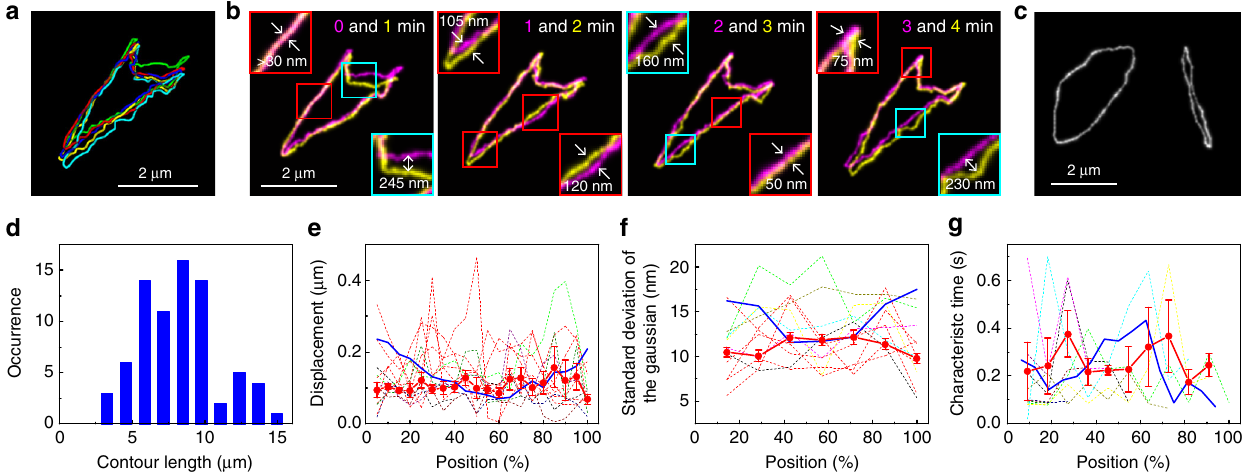
Fig. 6 Analysis of the motion of the entangled cyclic DNA molecules. a Superimposed 3D contours of the Cy5-labelled Charomid 9-42 DNA in an aqueous solution containing 10 mg ml − 1 concentration of non-labelled lambda DNA. b 2D projected contours of the DNA molecule displayed in a . The local widths of the contours correspond to the standard deviations of the Gaussian at each local segment. Two contours obtained from adjacent time frames are shown in each panel in cyan and yellow. Insets show enlarged views of the areas highlighted by the squares. c Examples of the 2D projected contours of the Cy5- labelled Charomid 9-42 DNA in an aqueous solution containing 10 mg ml − 1 concentration of non-labelled lambda DNA. d Frequency histogram of the contour lengths of Cy5-labelled Charomid 9-42 DNA determined by the 3D contours of the molecules. The contours of the molecules were obtained in an aqueous solution containing 7 – 10 mg ml − 1 concentration of non-labelled lambda DNA. e Mean position-dependent displacement of the Cy5-labelled Charomid 9-42 DNA occurring along the direction perpendicular to the contours during the time gap between the adjacent time frames in an aqueous solution containing 7 – 10 mg ml − 1 concentration of non-labelled lambda DNA (red line). f Mean position-dependent standard deviation of the Gaussian obtained from the Cy5-labelled Charomid 9-42 DNA in an aqueous solution containing 7 – 10 mg ml − 1 concentration of non-labelled lambda DNA by the fi tting of the local intensity pro fi les of the reconstructed super-resolution images at each segment (red line). g Mean position-dependent characteristic time obtained from the Cy5-labelled Charomid 9-42 DNA in an aqueous solution containing 7 – 10 mg ml − 1 concentration of non-labelled lambda DNA by the fi tting of the cumulative-area difference plots at each segment (red line). The error bars in e – g show standard error of the means determined using 12, 11, and 10 independent images of the DNA molecules, respectively. The dotted lines in e – g show the data obtained from the 12, 11, and 10 independent images of the DNA molecules. The blue line shows the data obtained from lambda direction perpendicular to the contour (Fig. 6e, see Methods for details of the analysis).